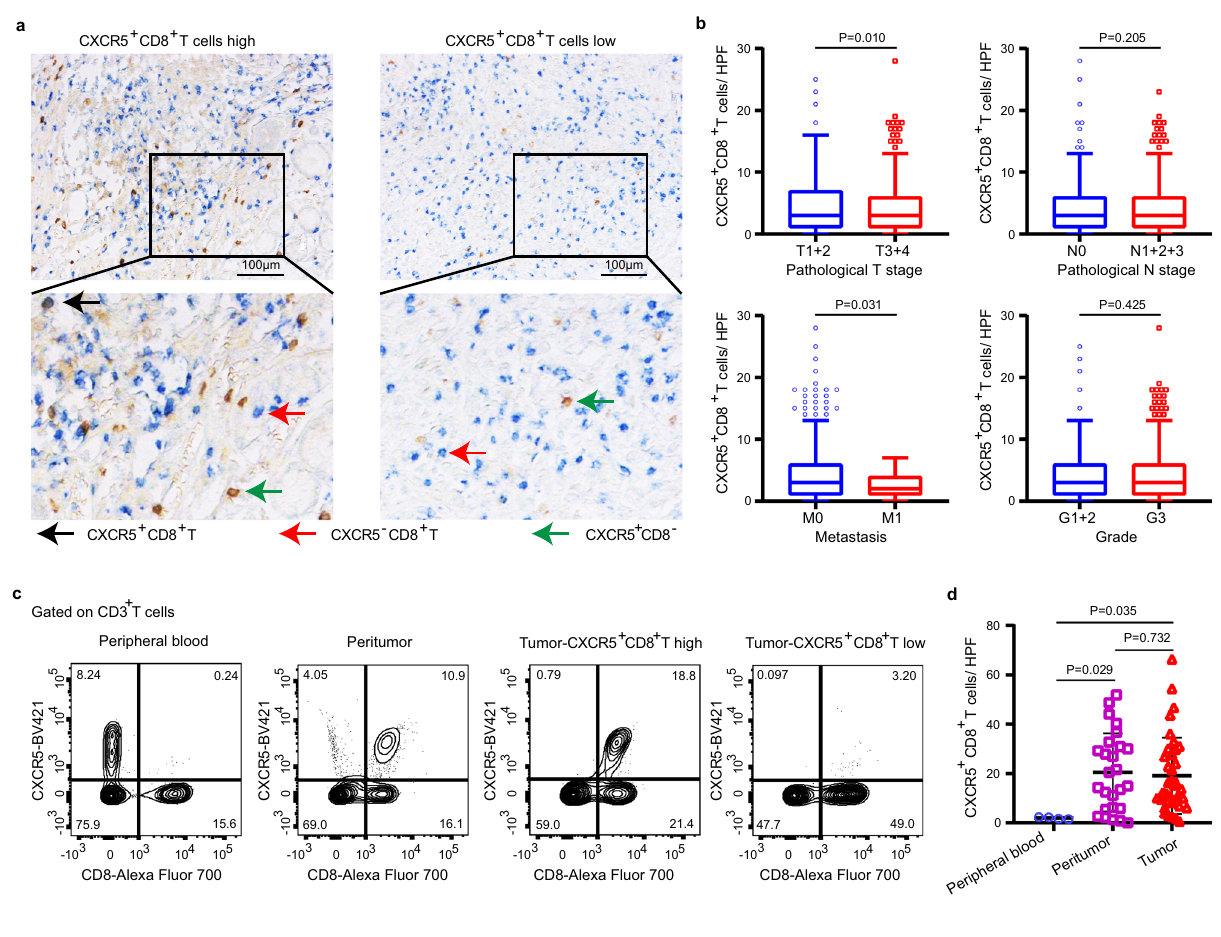
Fig. 1 The presence of CXCR5 + CD8 + T cells in GC. a Representative IHC images of high and low CXCR5 + CD8 + T cell in fi ltration in GC tissue. Representative staining out of three independent experiments is shown. b Association of CXCR5 + CD8 + T with pathological T stage, pathological N stage, metastasis, and grade in ZSHS and FUSCC combined cohorts. Graph shows minima, maxima, center, bounds of box and whiskers, and percentile of n = 781 patients with gastric cancer for pathological T stage ( n = 162 and n = 619 patients for T1 + 2 and T3 + 4 subgroups, respectively), pathological N stage ( n = 242 and n = 539 patients for N0 and N1 + 2 + 3 subgroups, respectively), metastasis ( n = 758 and n = 23 patients for M0 and M1 subgroups, respectively), and grade ( n = 192 and n = 589 patients for G1 + 2 and G3 subgroups, respectively). Statistical analysis by two-tailed unpaired t test. c Representative fl ow cytometric images of CXCR5 + CD8 + T cells in peripheral blood, peritumor, and tumor tissues. d The presence of CXCR5 + CD8 + T cells in peripheral blood, peritumor, and tumor tissues. Graph shows mean ± SD of n = 4 (peripheral blood), n = 26 (peritumor tissues), and n = 37 (tumor tissues) individual patients. Statistical analysis by two-tailed unpaired t test. Source data are provided as a Source data fi le. HPF high-power